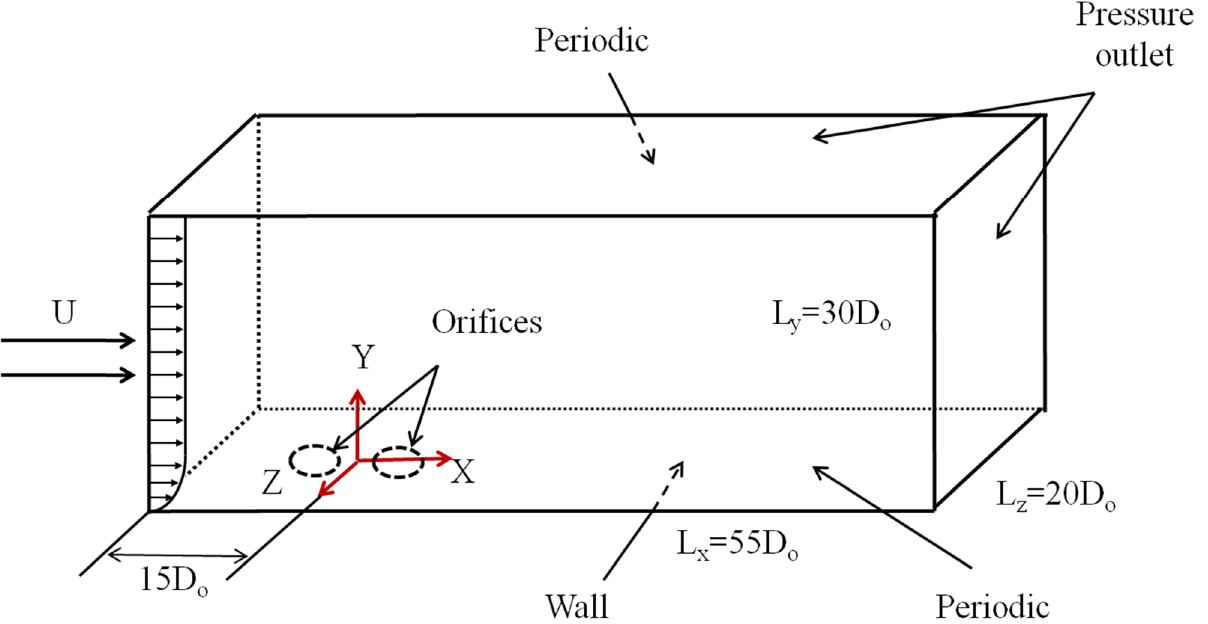
Figure 1. Computational geometry and boundary conditions for current CFD simulations. The actuator cavities are included in the simulation (although the cavities are not presented). The orifices of the two actuators are presented as dash circles located close to the origin of the coordination.